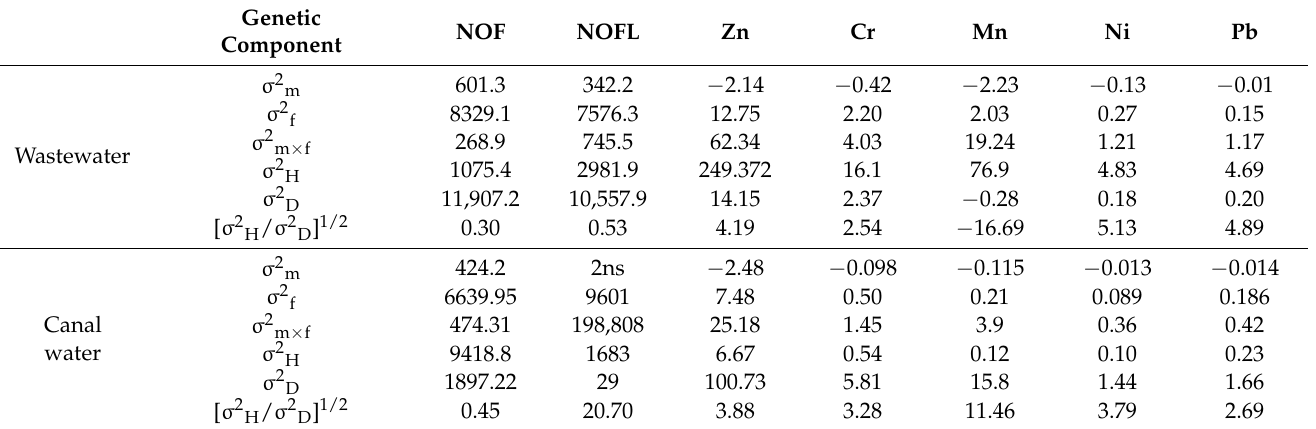
Table 2. Genetic components of variation for yield and HMs accumulation under wastewater and canal water irrigation (North Carolina matting design-II).